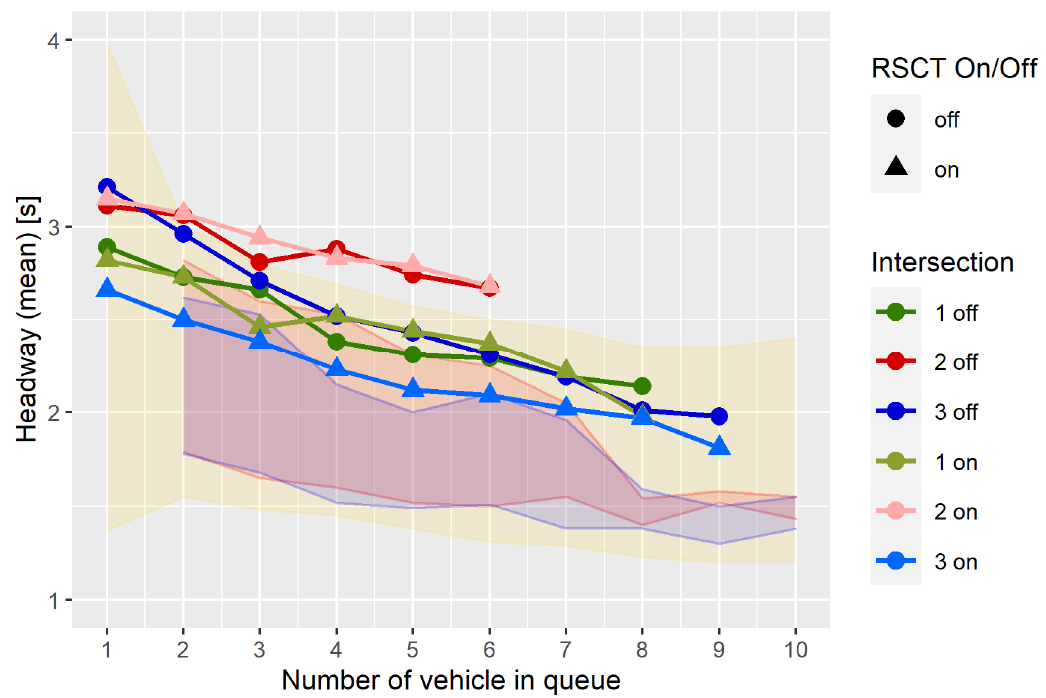
Figure 8. Headways between vehicles during queue start (description of filled areas given in text).